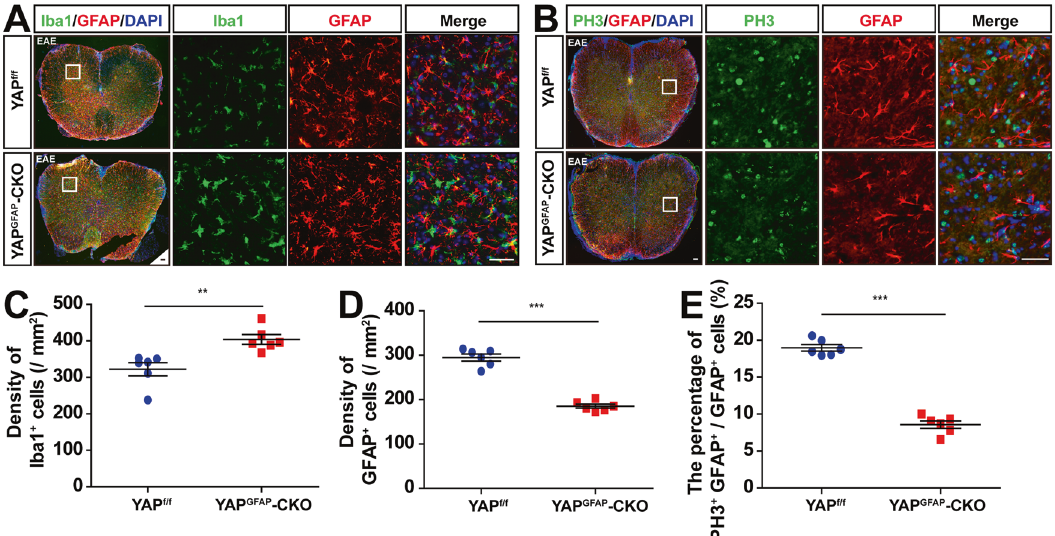
Fig. 4 The neuroin fl ammation was aggravated and the proliferation of astrocytes was reduced in the spinal cords of YAP GFAP -CKO EAE mice. A , B Immunostaining of Iba1 (green) and GFAP (red) ( A ), and PH3 (green) and GFAP (red) ( B ) in the lumbar spinal cords of YAP f/f and YAP GFAP -CKO EAE mice. C , D Quanti fi cation of the density of Iba1 + ( C ) and GFAP + ( D ) cells in shown in A ( n = 6). E Quanti fi cation of the percentage of PH3 + and GFAP + cells over total GFAP + cells in one fi eld as shown in B ( n = 6). Scale bars, 50 μ m. Data were mean ± SEM. Student ’ s t -test, ** p < 0.01, *** p < addition, double immunostaining revealed that the expression of HMGCS1 was signi fi cantly decreased in astrocytes of the lumbar spinal cord of YAP GFAP -CKO EAE mice (Fig. 5H, I). Taken together,